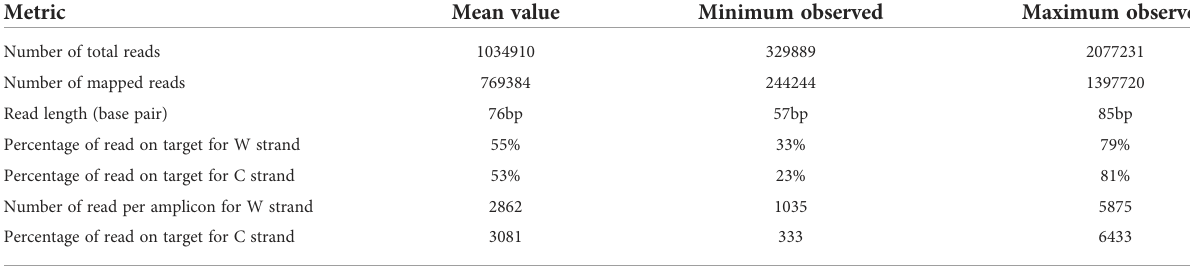
TABLE 2 Metrics per sample obtained using the OPERA_MET-A panel for targeted bisul fi te NGS. Metric Mean value Minimum observed Maximum